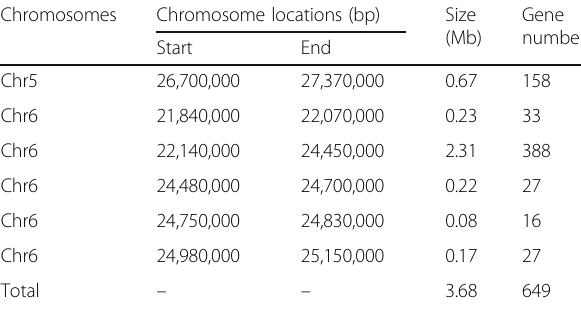
Table 4 Information of the association region by the SNP-index association analysis